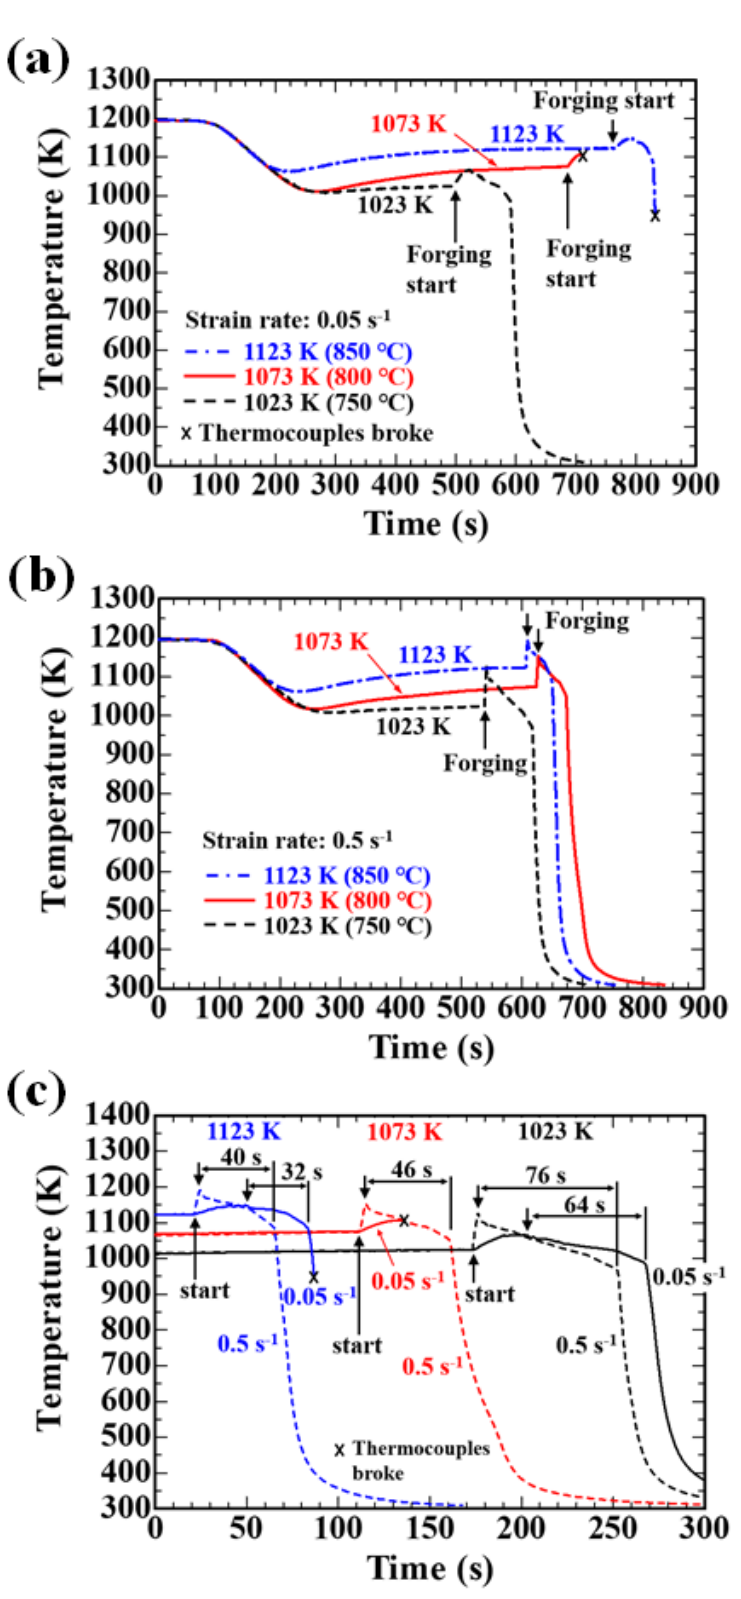
Figure 4. Temperature changes for the strain rates of ( a ) 0.05 s −1 and ( b ) 0.5 s −1 during the β -processed forging and subsequent cooling. ( c ) The enlarged temperature changes from forging to cooling. The starting time of the forgings was discretionally justified at each temperature in ( c ).